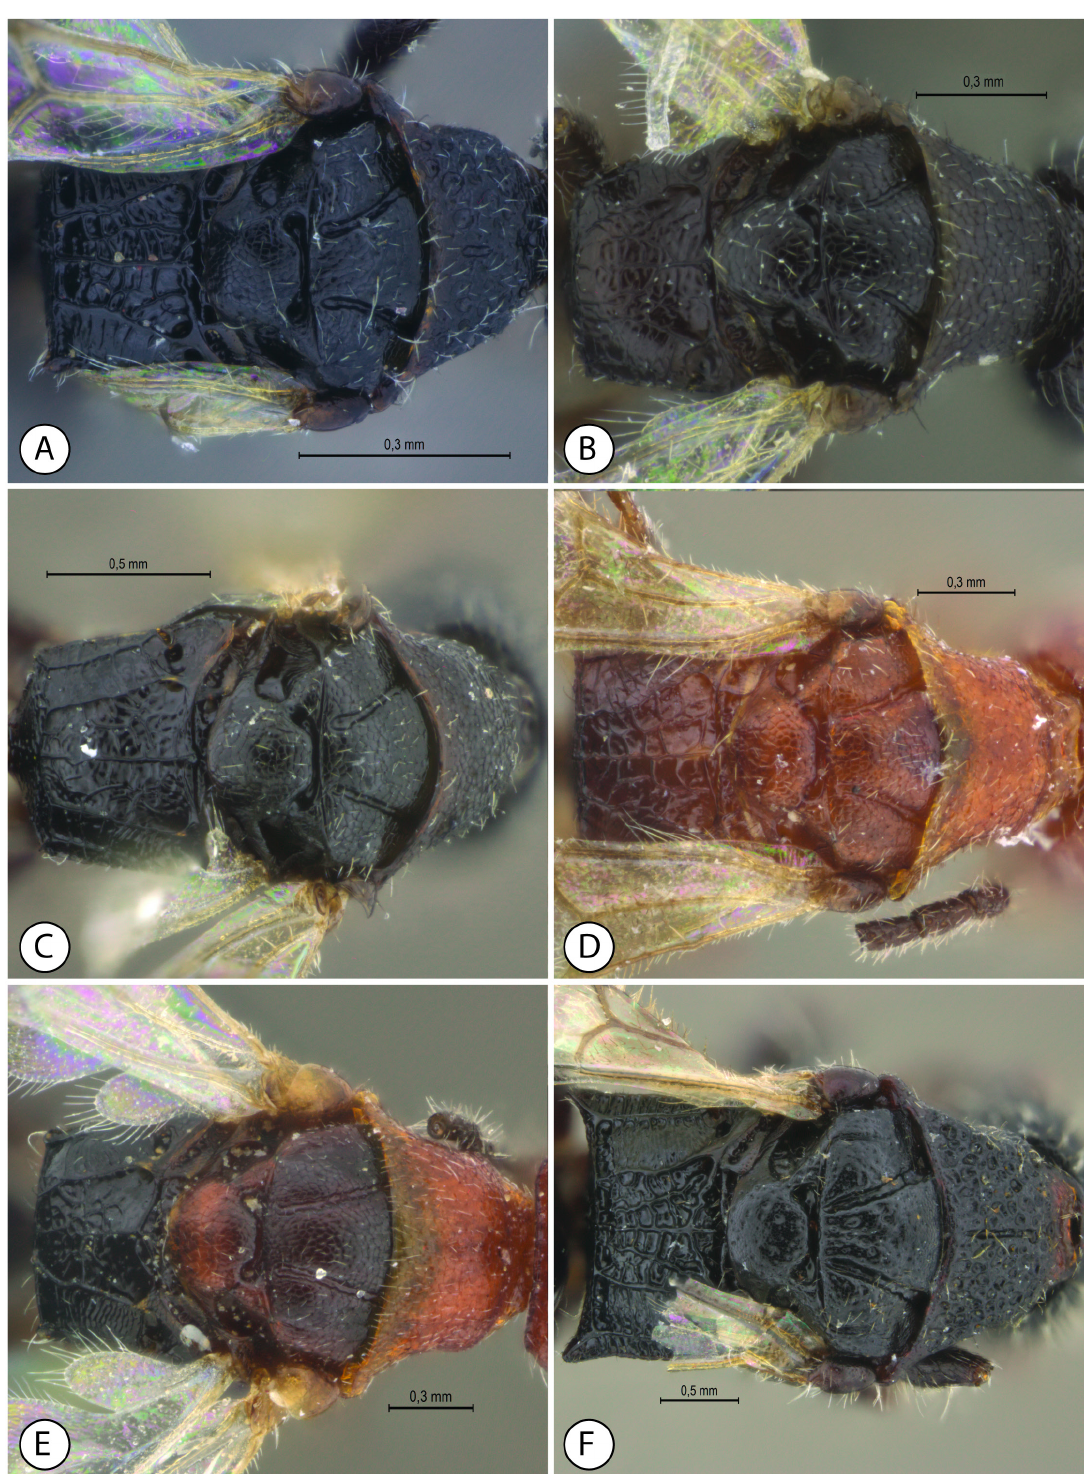
Fig. 1. Mesosoma of Astromesitius gen. nov., dorsal view. A . A. olavoi gen. et sp. nov. (holotype, QBG) B . A. thionyi gen. et sp. nov. (holotype, UFES 118956) C . A. carbonarius (Móczár, 1970) gen. et comb. nov. (UFES 56168) D . A. indistintus (Barbosa & Azevedo, 2011) gen. et comb. nov. (paratype, UFES) E . A. minutissimus (Móczár, 1971) gen. et comb. nov. (holotype, UFES 56528) F . A. quatei (Móczár, 1977) gen. et comb. nov. (holotype,